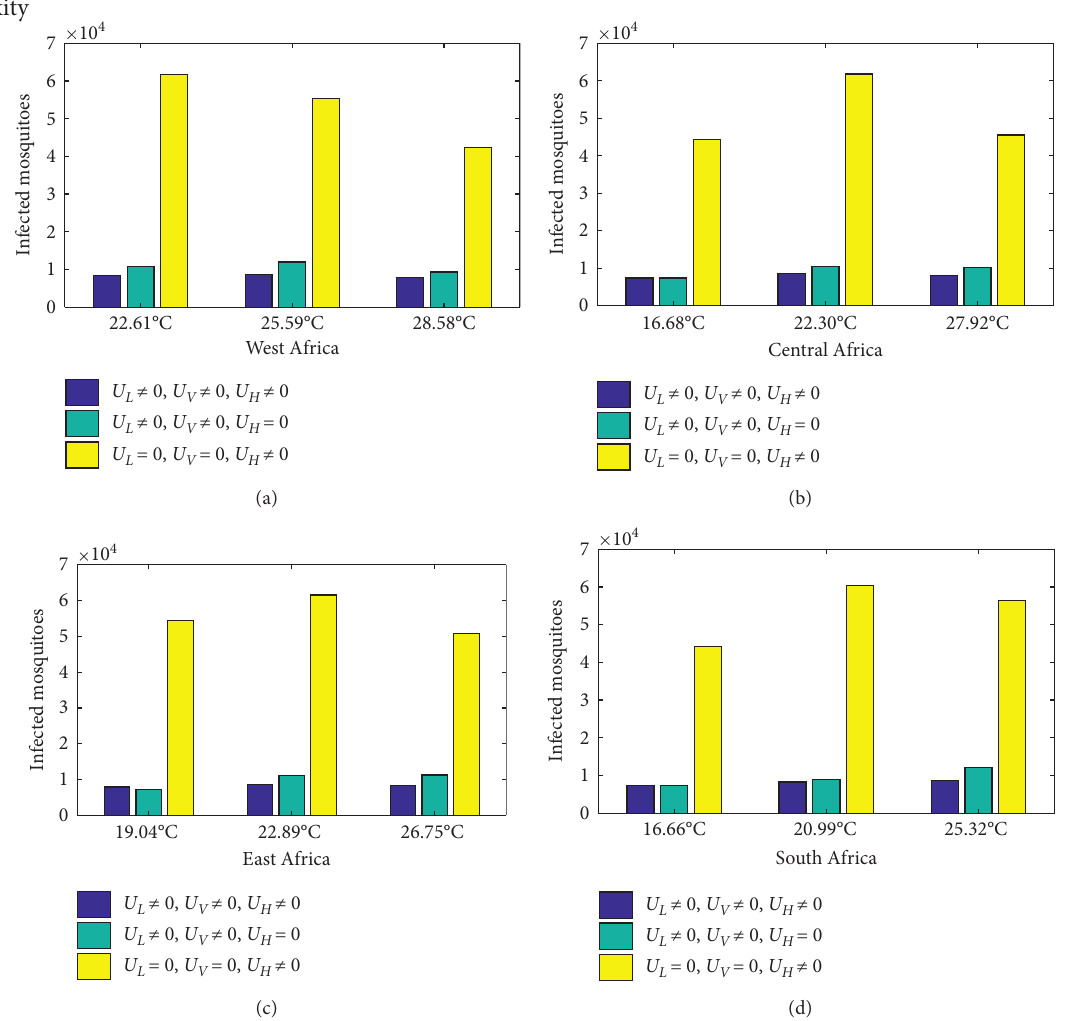
Figure 17: Simulations of the malaria model (2) as a function of time plotting the average control levels for controls u Central, East, and Central